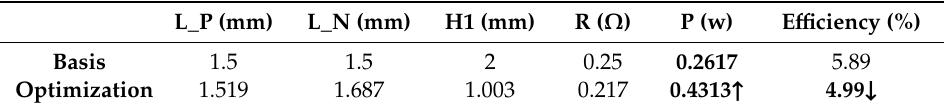
Table 2. Optimization